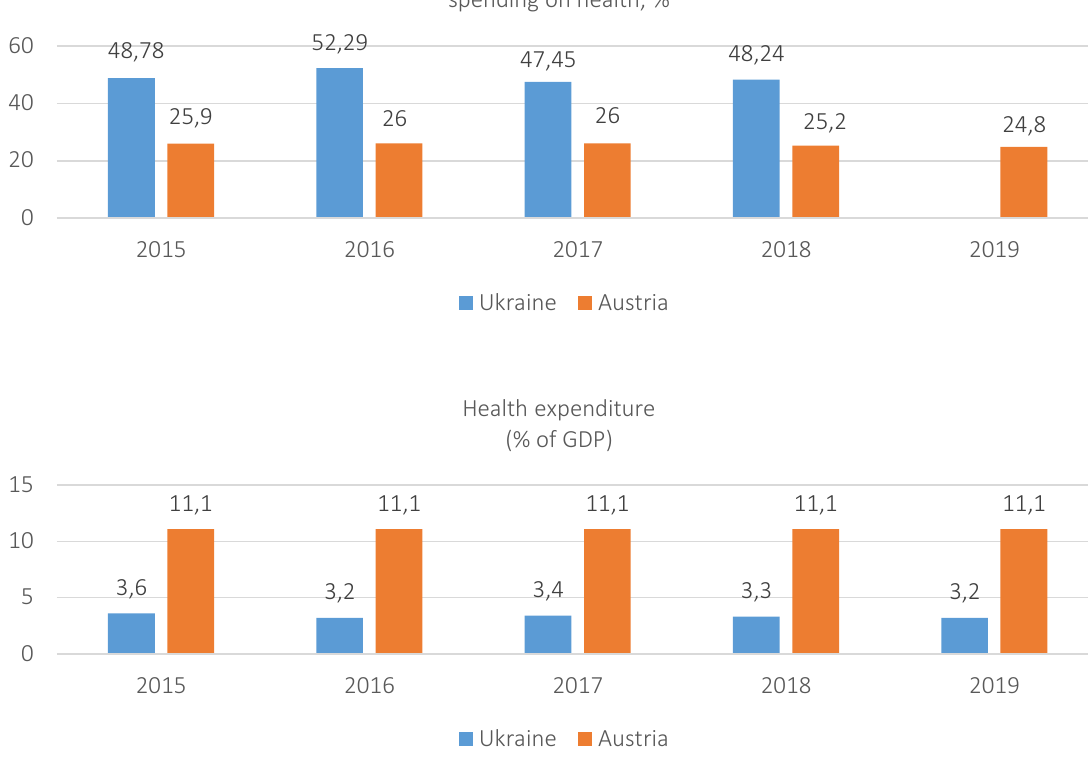
Figure 3. Healthcare state financing dynamics in Ukraine and Austria